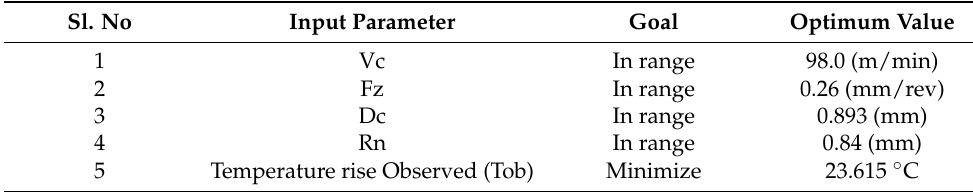
Table 5. Optimum values during turning of aluminium.